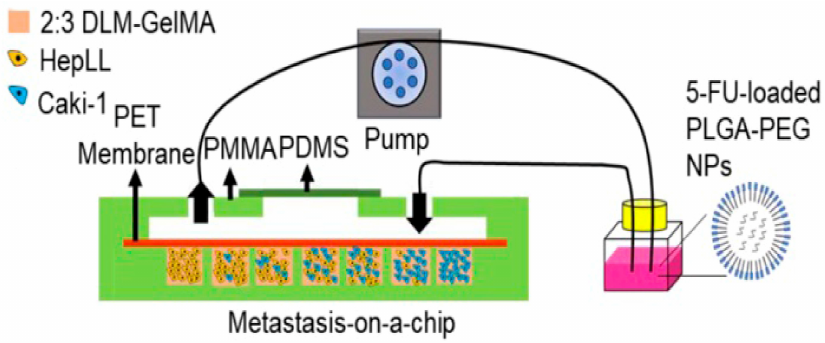
Figure 7. The metastasis-on-a-chip platform. Reproduced with permission